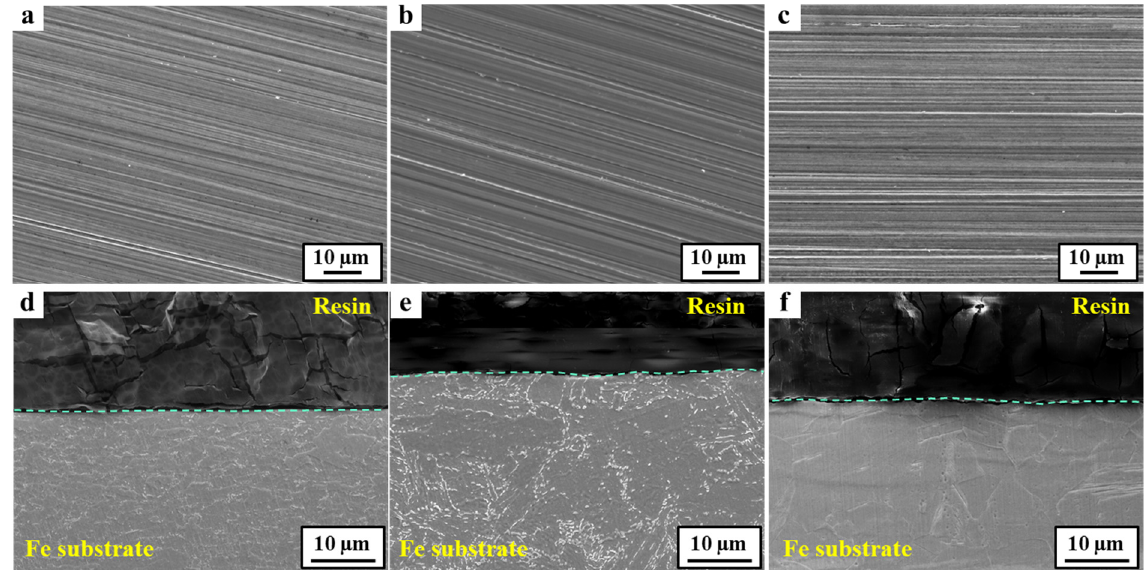
Figure 4. FE-SEM images of the tested samples before immersion. ( a – c ) Surface images of APIX70, 9Ni, and 24Mn3Cr, respectively; ( d – f ) Cross-sectional images of APIX70, 9Ni, and 24Mn3Cr, respectively.